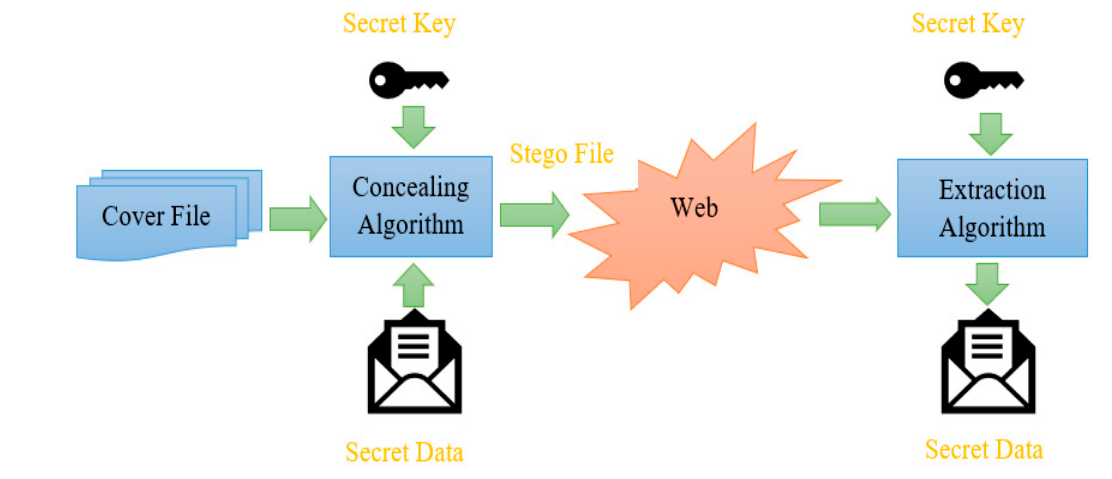
Figure 1. Steganography Process.